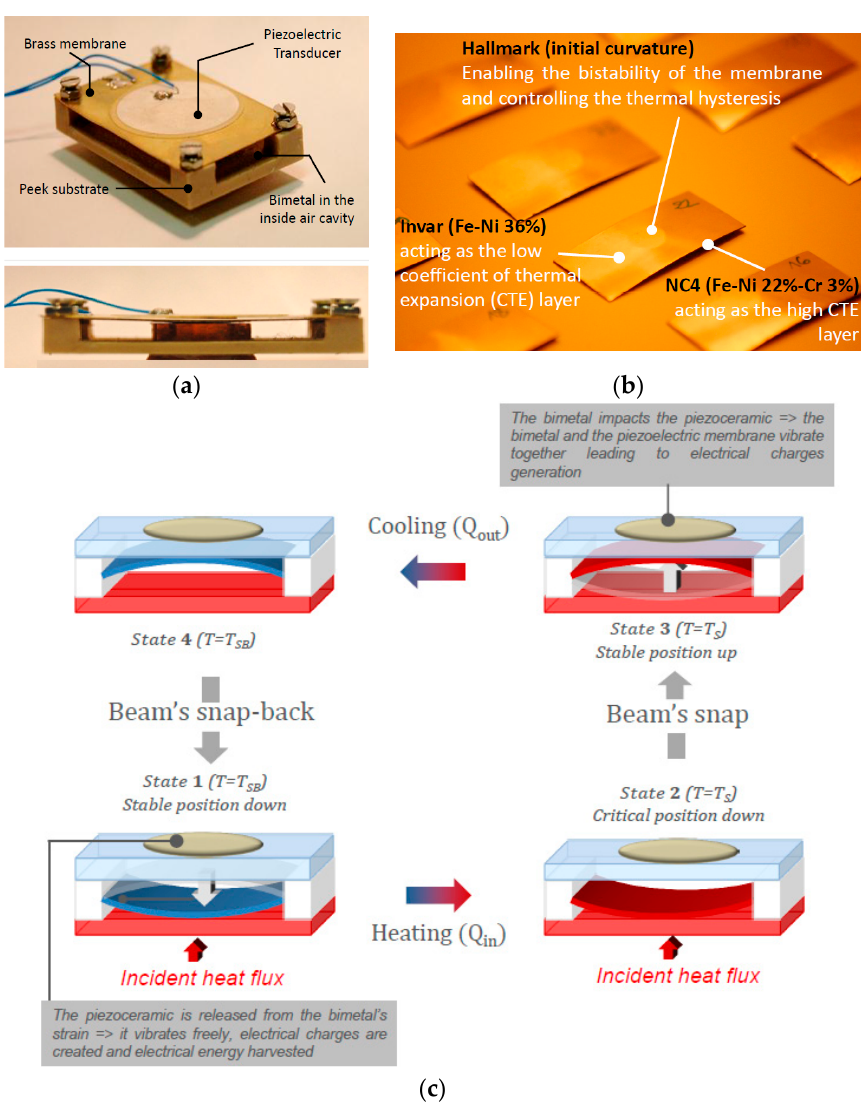
Figure 1. ( a ) Thermal energy harvester previously developed based on a piezoelectric membrane and a bimetallic strip in the inside air cavity; ( b ) Image of the precurved bimetal; ( c ) Working principle of the harvester and different states of the bimetal.